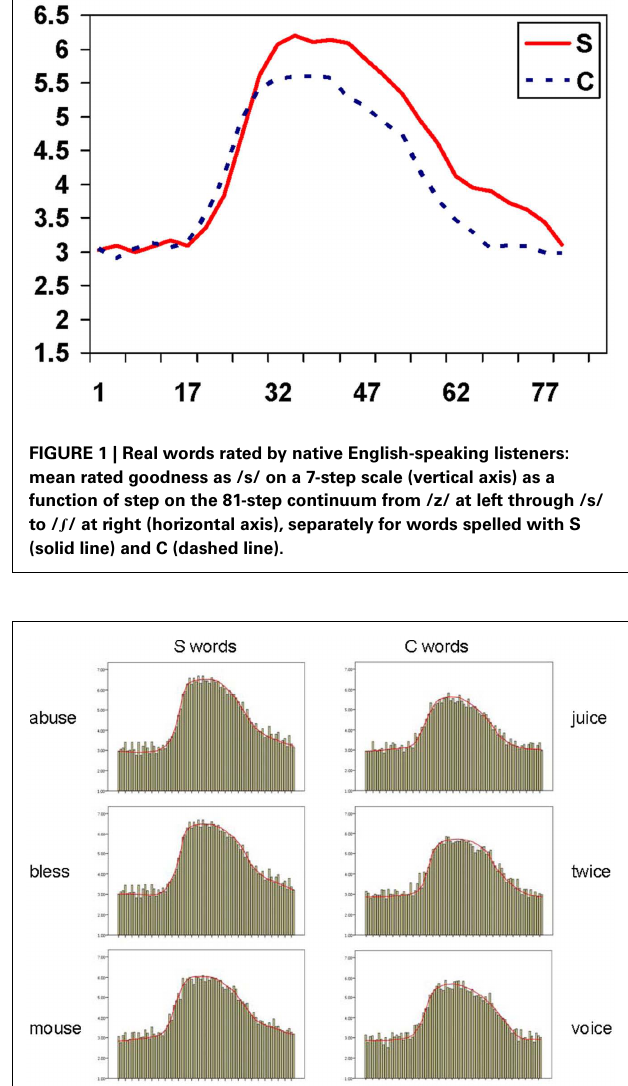
Table 1 | Non-word pre-test: percentage of non-words spelled with S and with C, as a function of orthographic neighborhood.